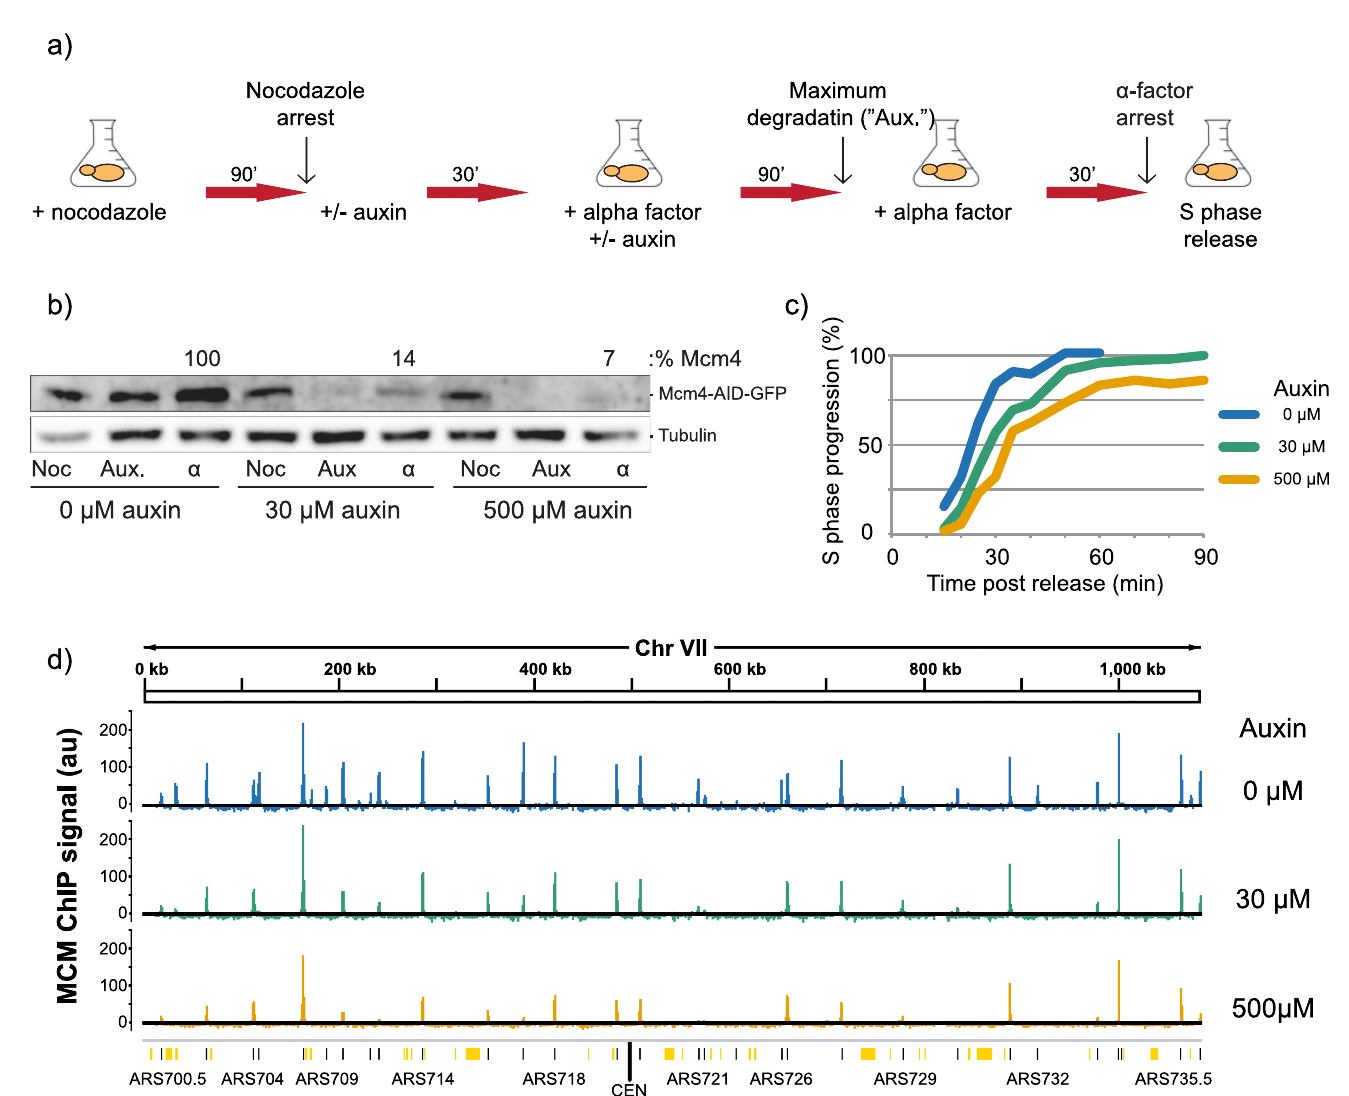
Fig 1. Reduction of MCM pools through auxin-mediated degradation of Mcm4. a) Experimental outline for MCM reduction experiments. yFS1059 cells were first synchronized with nocodazole, then released into α -factor for a G1/S arrest, prior to release into S phase. Flask symbol indicates filtering and release into new media, with additives as indicated. b) Western blot showing the levels of auxin-inducible cells (yFS1059) at the indicated time points of the experiment, probed using an anti- GFP antibody tracking GFP-tagged Mcm4. Noc = nocodazole arrest, Aux = maximum auxin degradation, α = α -factor arrest. Boxed value indicates quantitation of Mcm4-IAA17-GFP levels in α -factor arrested cells treated with 0 μ M, 30 μ M, or 500 μ M auxin relative to levels of 0 μ M auxin cells. c) Quantitation of flow cytometry data as cells progress from α -factor arrest through S phase. d) Normalized MNase-ChIP-seq coverage on Chromosome VII in 1 kb bins. ARS-annotated origins are shown as black lines whereas potential, non-experimentally-confirmed origins are shown as orange lines/boxes [63].